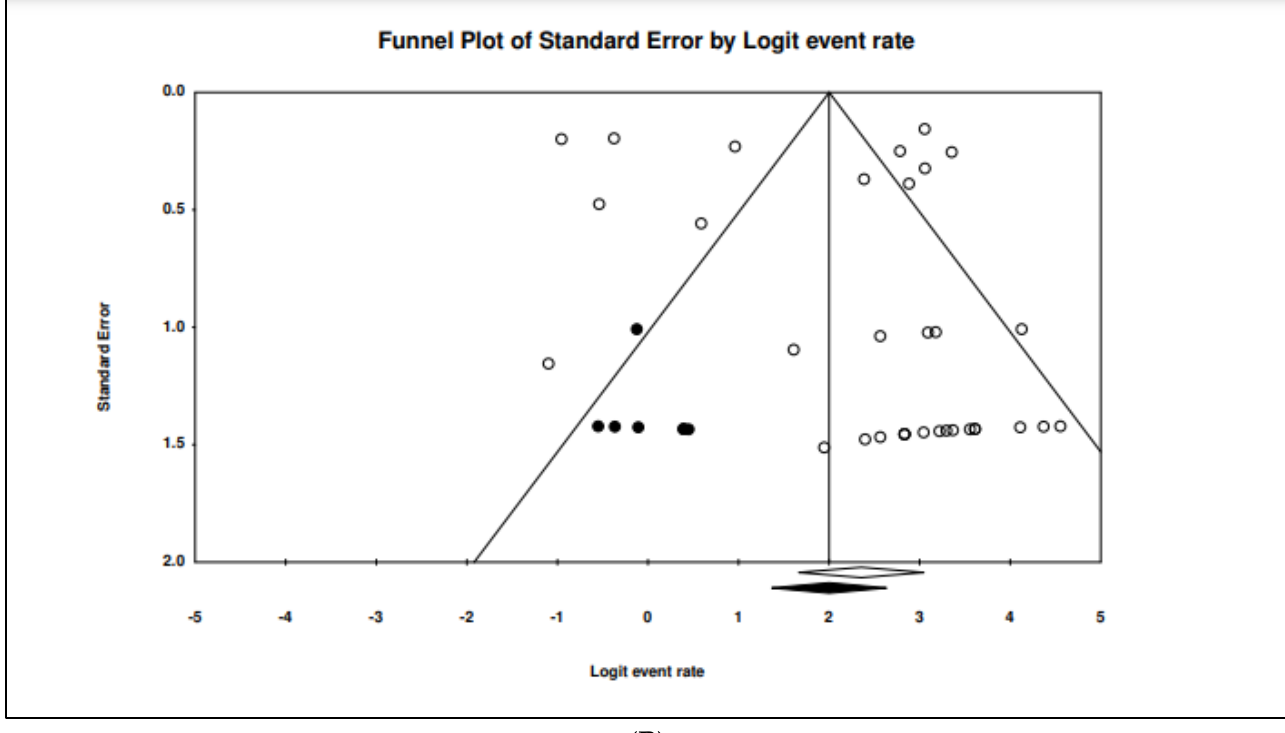
Figure 6. Funnel plot showing ( A ) publication bias in studies reporting the prevalence of gyrA gene in antimicrobial resistant S. Typhi and ( B ) result after performing the trim-and-fill method where seven missing studies (closed circles) were added on the left side of the mean effect. Table 3. Sub-group analysis of prevalence of gyrA gene in S. Typhi according to countries and re- gions.